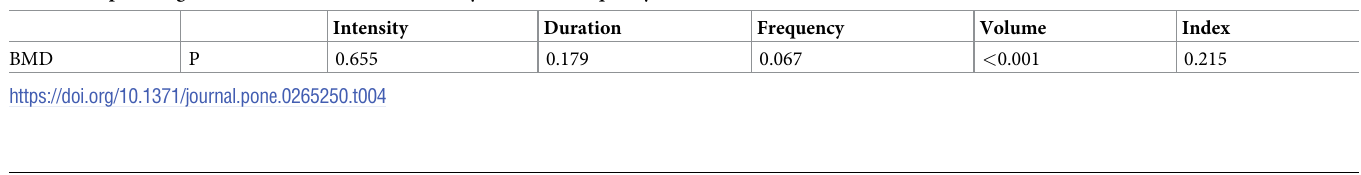
Table 4. Stepwise regression between BMD and intensity, duration, frequency, volume and